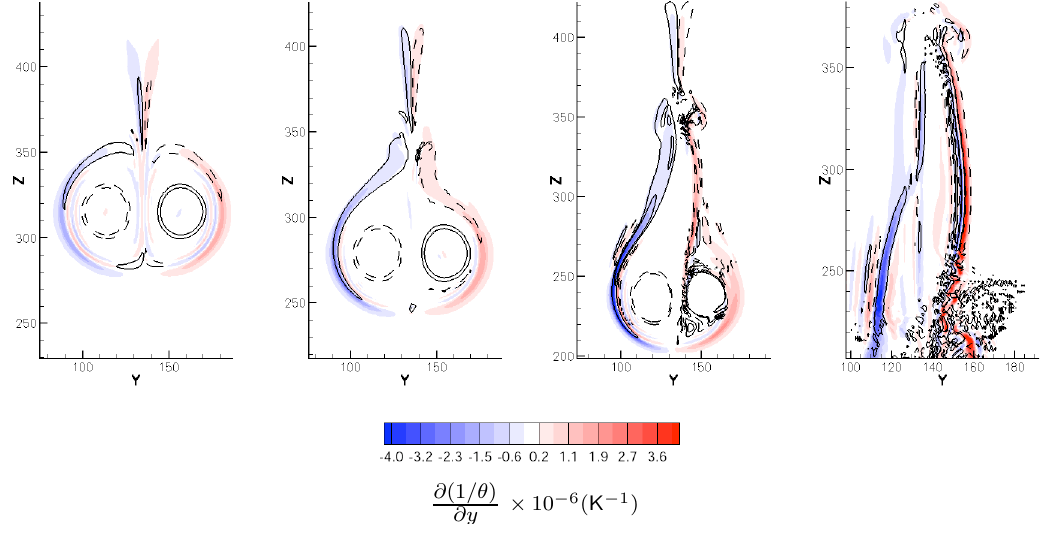
Fig. 3. Generation of the secondary wake in the cross-section yz at x = 200m (axial location of minimal vortex spacing). Isocontours of the source of axial vorticity: ∂ 1 /θ (see Eq. 15) and isolines of axial vorticity (4 levels between − 0 . 5s − 1 and 0 . 5s − 1 ). From left to right: ∂y t = 60s , 80s , 100s and 120s (Run V